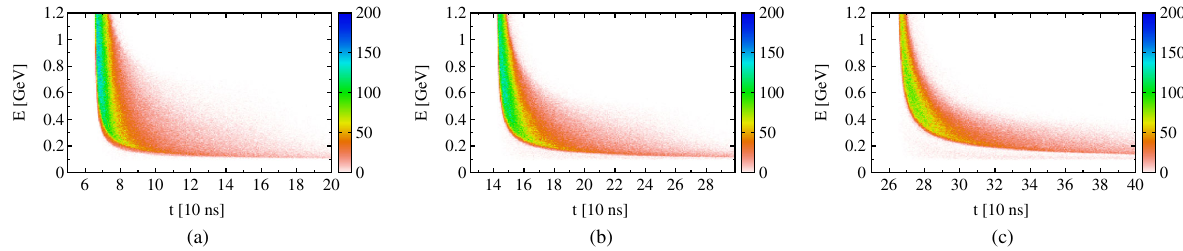
FIG. 8. Progression of the longitudinal phase space of pions inside [8(a)] and after exiting [Figs. 8(b) and 8(c)] from a 40 m long tapered solenoid. (a) z ¼ 20 m . (b) z ¼ 40 m . (c) z ¼ 80 m